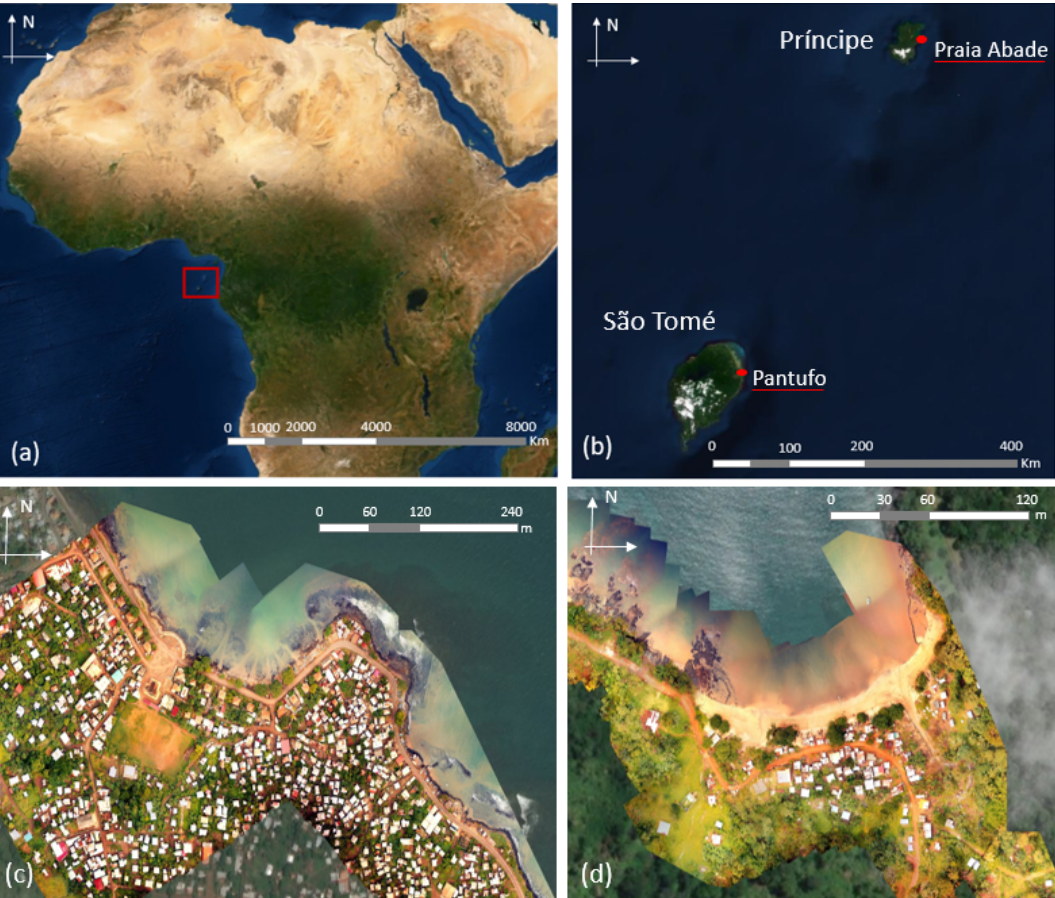
Figure 1. Case study site. (a) Geographical location of the islands of São Tomé and Príncipe in the Gulf of Guinea. (b) Geographical location of the communities of Pantufo and Praia Abade on the two islands. (c) Aerial view of the communities of Pantufo and (d) Praia Abade. Panels (a) and (b) are provided by ESRI, DigitalGlobe and the GIS community. Panels (c) and (d) were reproduced with permission from CDR